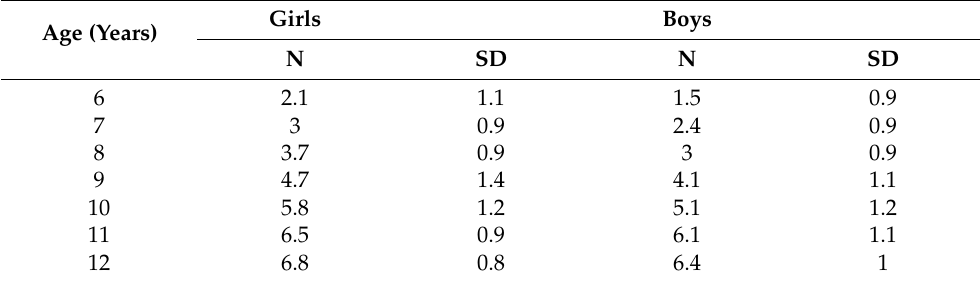
Table 2. Mean number (N) and standard deviation (SD) of erupted left lower mandible teeth (dental state) in the school children of Kupang (West-Timor).